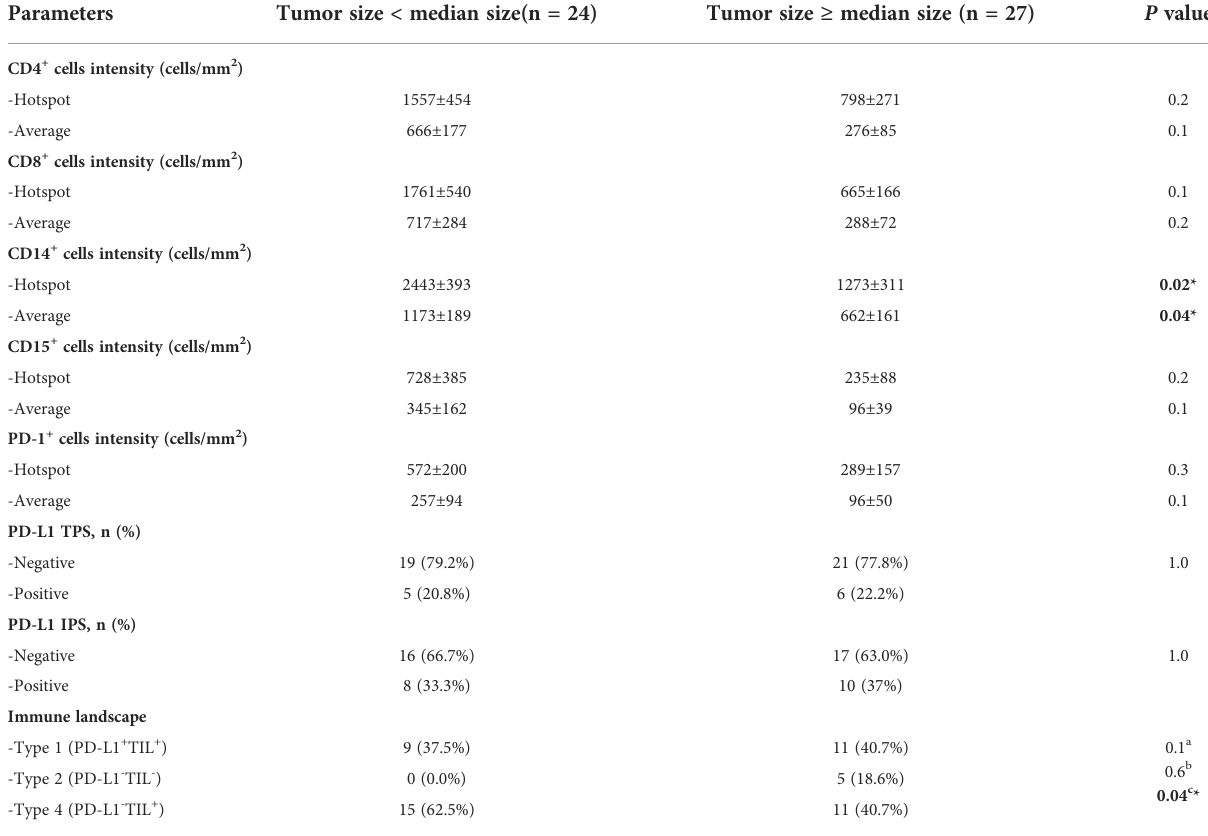
TABLE 3 Correlation analysis of immune phenotype and tumor size in T-NEN